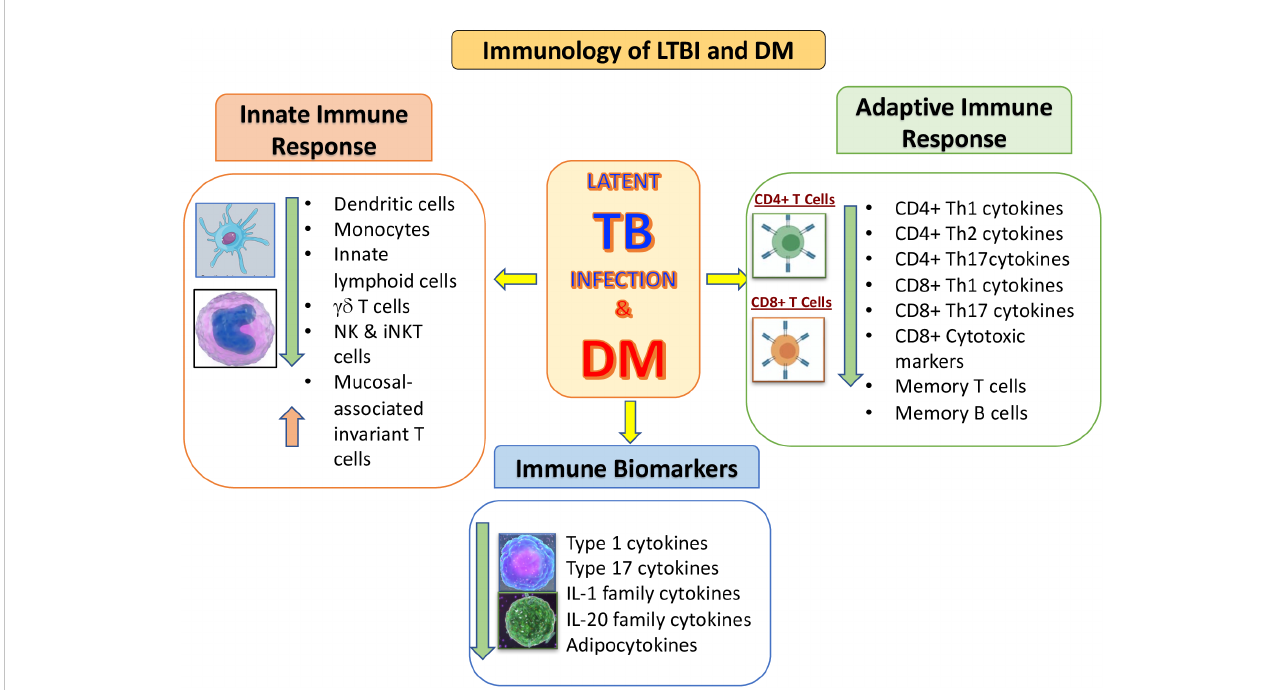
FIGURE 1 Summary of the immunological interactions between latent tuberculosis infection (LTBI) and type 2 diabetes mellitus (DM) . The outcomes of DM on the distinctive arms of the innate and adaptive immune systems is represented by arrows indicating increased or decreased function compared to LTBI without